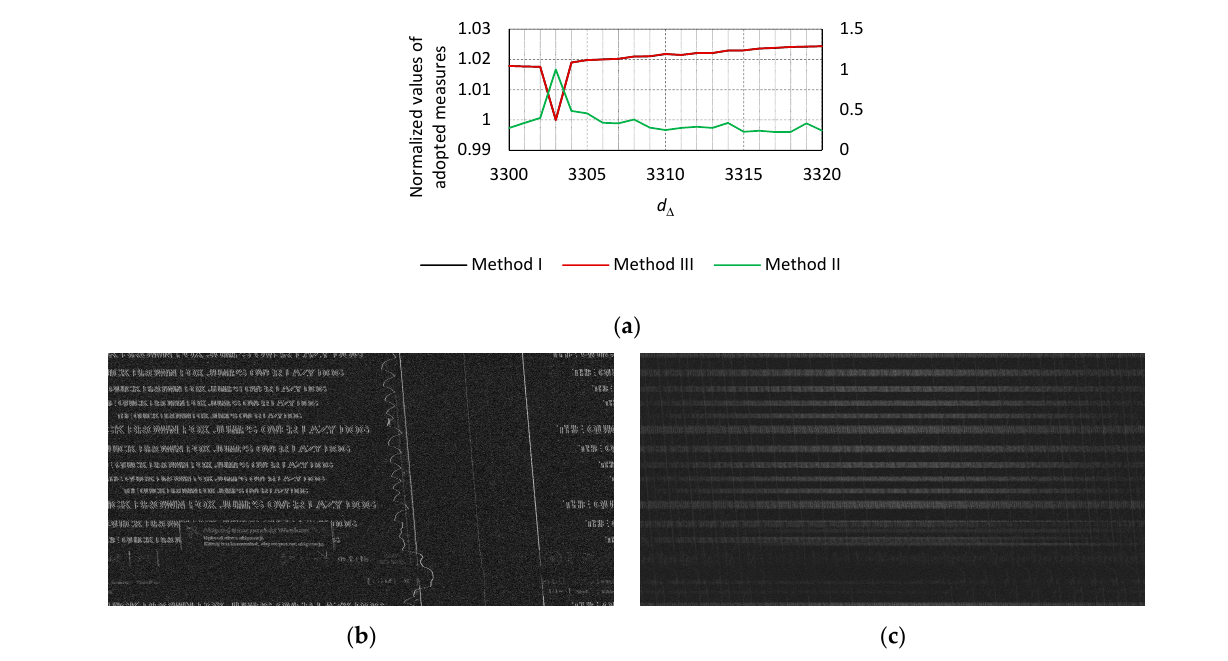
Figure 30. ( a ) The normalized values of the adopted measures (method I, II and III) calculated in domain of image line length d ∆ for the accuracy ∆ = 1.0 (for the original image shown in Figure 7e) and images reconstructed on the basis of the recorded revealing emission signals at frequency f o = 450 MHz (receiving bandwidth BW = 50 MHz, accuracy ∆ = 1.0), ( b ) for estimated line length d ∆ = 3303.00000, image summation multiple Sum MTL = 1 and ( c ) for estimated line length d ∆ = 3300.00000, multiple of image summation Sum MTL = 15 —the source of revealing signal emission—display monitor, VGA standard.